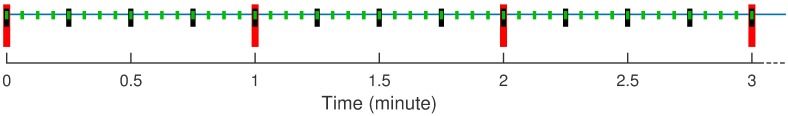
PhysiCell and multiple time scales.PhysiCell uses BioFVM to update the microenvironment at the short green tick marks, corresponding to Δtdiff. It updates cell mechanics (including cell position) less frequently at the medium black tick marks (Δtmech), and it runs the cell volume and cycle/death models least frequently at the long red tick marks (Δtcell). Note that the time steps shown are for illustrative purpose; the default step sizes are given in Time steps.